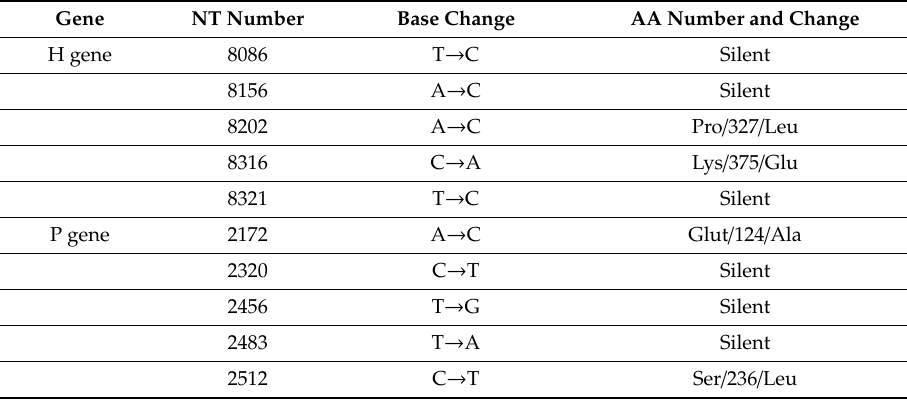
Table 2. Synapomorphic Changes in Serengeti